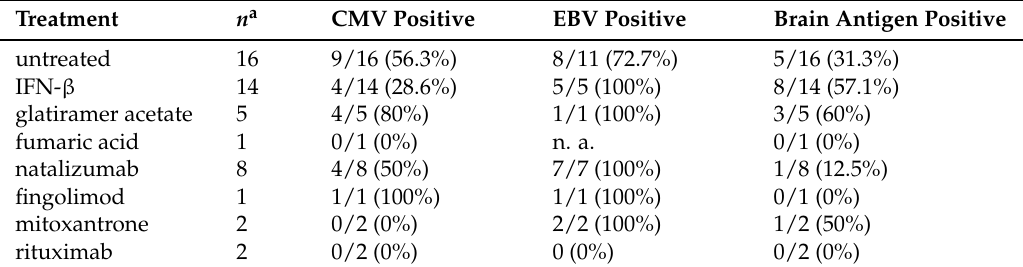
Table 3. Immune modulatory treatment of MS patients included in the